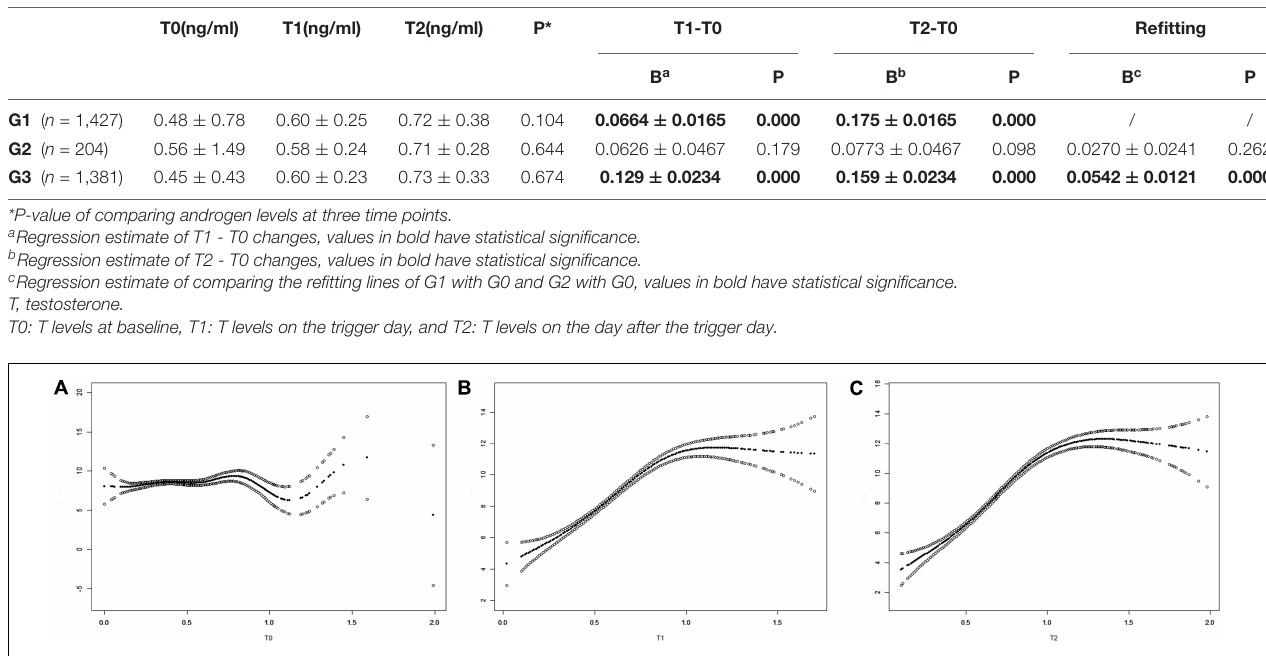
presented a similar trend with that of T levels and oocytes retrieved with corresponding inflection points, except for that of T levels and TQE formation